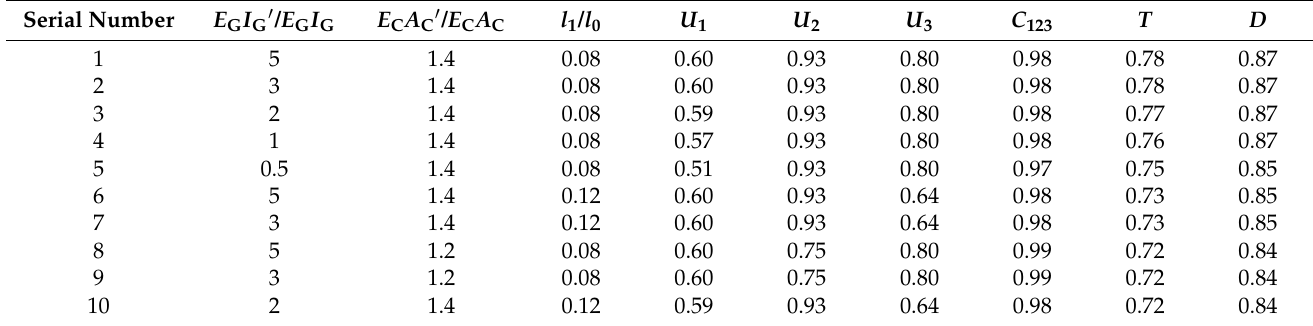
Table 6. Calculation results of three-parameter coupling coordination.